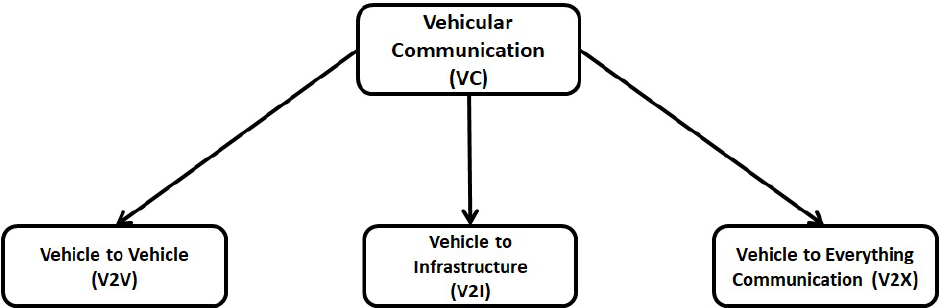
Figure 5. Vehicular communication (VC)